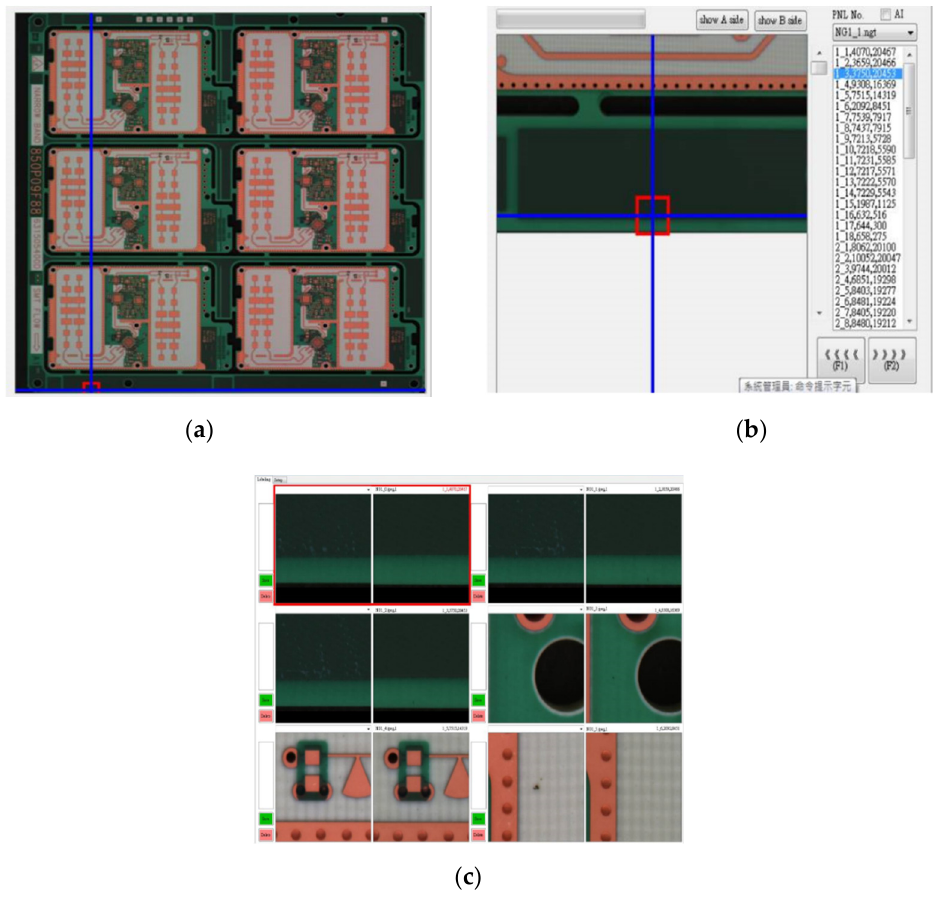
Figure 2. Sections of the user interface. ( a ) Printed circuit board (PCB) panels. ( b ) Cropped or enlarged section of the defective region. ( c ) Cropped or enlarged area of the reference sample.